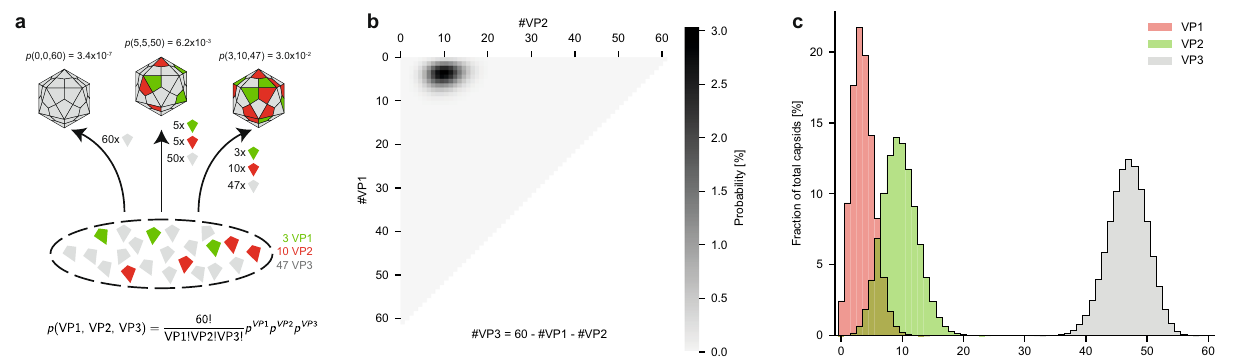
Fig. 3 Stochastic assembly model for complete AAV capsids. a Illustration of AAV capsid assembly following a stochastic model, where VPs are drawn randomly from the pool of expressed VPs. The probability for each capsid stoichiometry is solely determined by the ratio of the expressed VPs. Here displayed for AAV9 and the experimentally determined expression levels of 6% VP1, 16% VP2, and 78% VP3 or approximately 3:10:47 (VP1:VP2:VP3). The probabilities for exemplary VP stoichiometries are indicated above each capsid, respectively. b The calculated probabilities for all possible 1891 capsid stoichiometries are displayed as a heat map. The number of VP1 and VP2 in the 60-subunit capsids are indicated on the plot axis. c Summed probabilities for capsids having a speci fi c number of VP1, VP2, or VP3 in their capsid.